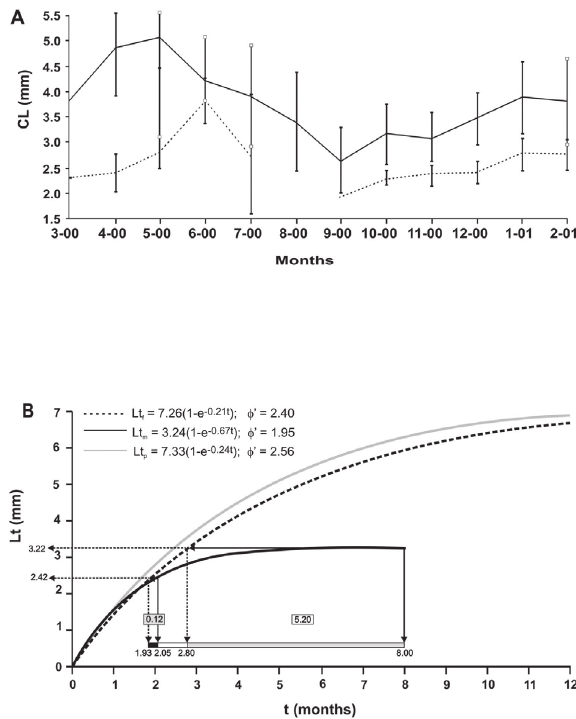
Fig . 6. – a. Monthly evolution of the mean size (CL: carapace length) and its standard deviation by sexes. Females: continuous line, males: discontinuous line. b: absolute growth models of H. inermis . Females: discontinuous line (Ltf: total length for females), males: continuous black line (Ltm: total length for males), and the whole population: continuous grey line (Ltp: total length for the whole population). Continuous line with arrows: sizes and ages of males. Discontinuous line with arrows: sizes and ages of females. Fig . 5. – a. relationship between relative frequency of ovigerous bar: Possible sex reversal age ranges; black: minimum, grey: maxi- females (oF (%)) and size (CL (mm)). b. relationship between ac- mum. Lt: total cumulated frequency of ovigerous females (oF (%)) and size (CL (mm)). C. relationship between the mean number of eggs (neggs/ oF) by ovigerous female and the size (CL (mm)) (exponential regression).